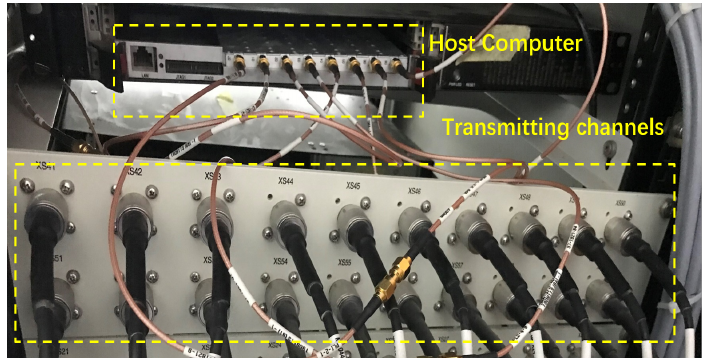
Figure 11. The main controller and transmitting